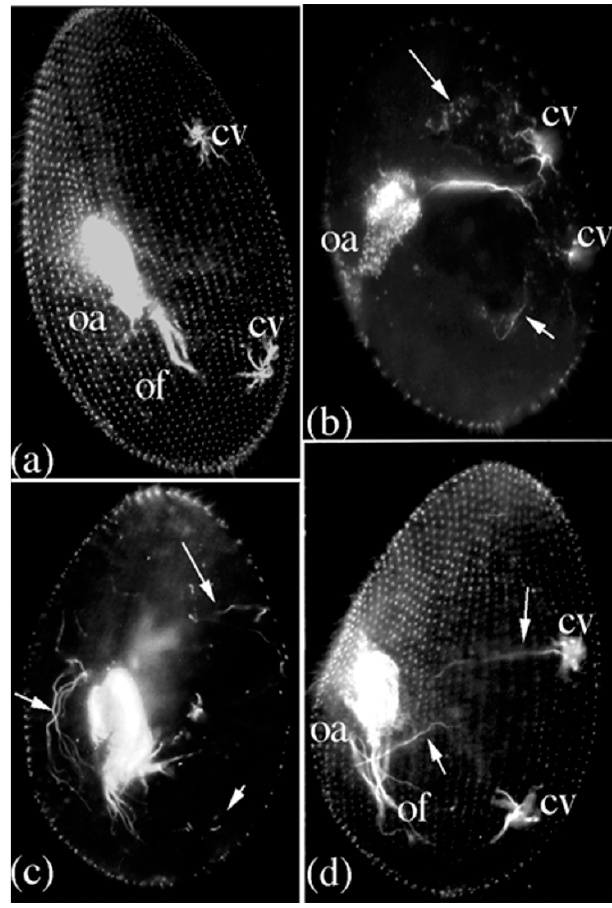
Figure 2 Cytological abnormalities induced by inactivation of the δ PT1 gene: cellular level. (a): surface view of the dor- sal side of a control cell, showing the basal body pattern, the outline of the oral apparatus (oa) and post-oral fibers (of) and the contractile vacuole pores and rootlets (cv). (b), (c), and (d): transformed cells from the pool presented in Table 1. (b), (c): sub-surface view of two transformed cells, showing disorders in the organization of the oral apparatus and pos- toral fibers, and the presence of erratic microtubule bundles (short arrows) and groups of intracytoplasmic basal bodies (arrows). (d): dorso-lateral view of a transformed cell show- ing erratic microtubule bundles (short arrows) and altered organization of oral apparatus and post-oral fibers. Note that the three transformed cells display a less constrained shape than the control. Bar for 10 μ M : 0.5cm